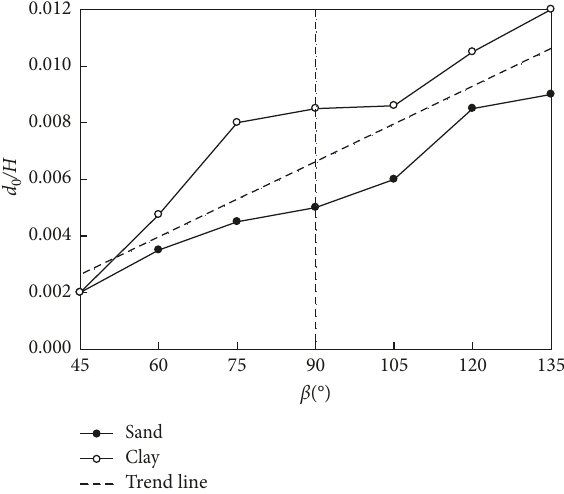
0 / H and the fault dip